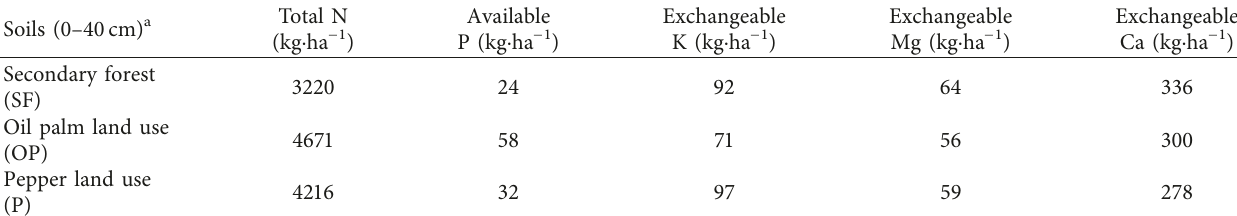
Figure 3: Pepper cultivation (1 year old) under sandy-textured soils at the Sabal area. Table 6: Soil nutrient stocks in various agricultural land